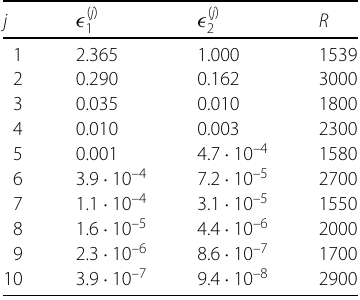
Table 5 (cid:15) ( j ) , (cid:15) ( j ) , j = 1, ... , N and the respective Rayleigh number R in which the maximum takes place 1 2 for different dimensions j of the reduced basis space. R is in the interval [1538;3000] for solutions S